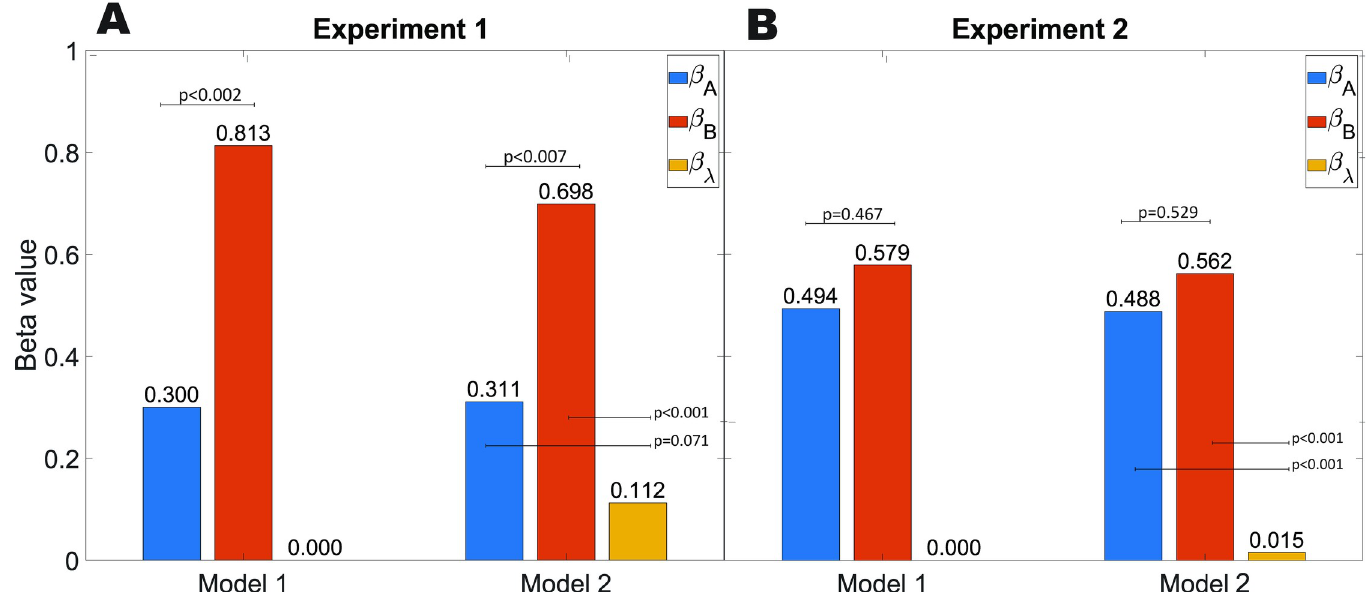
Fig 3. Mean Beta values from the vector models. (A): experiment 1 and (B): experiment 2.